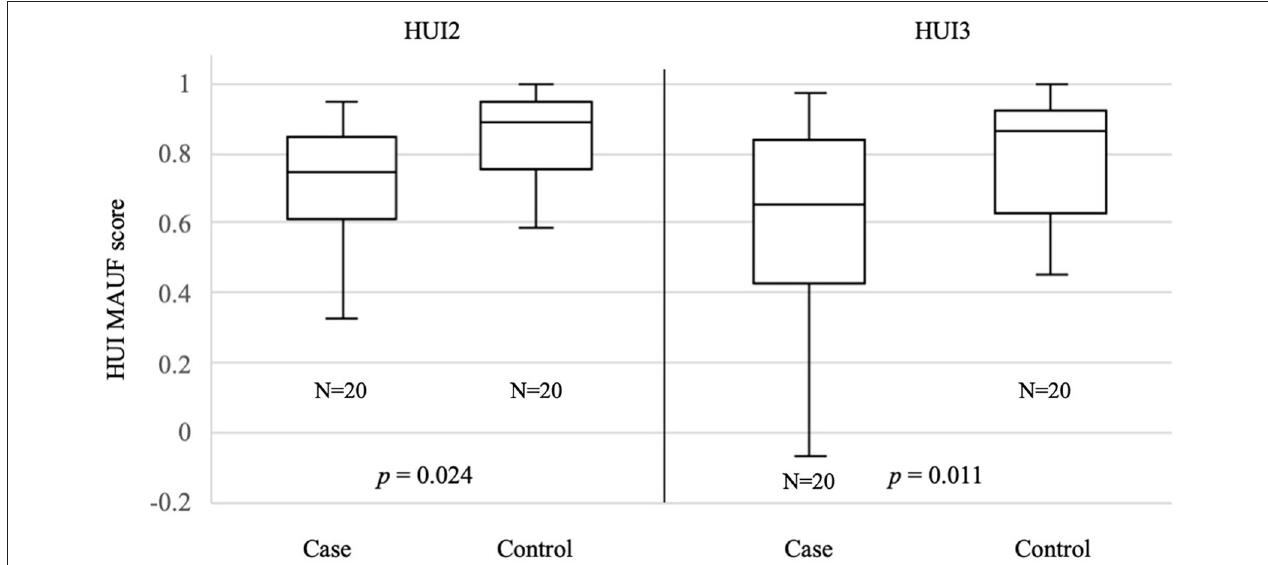
FIGURE 2 | Median HUI MAUF scores for case and control